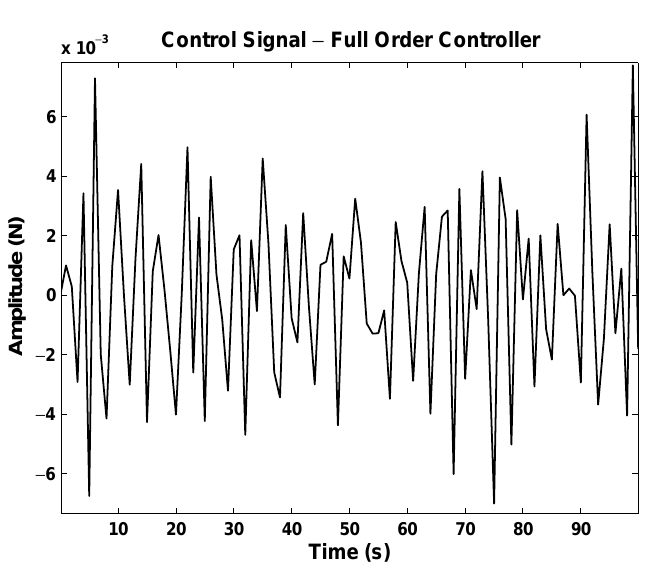
Fig. 11. Control signal – full order